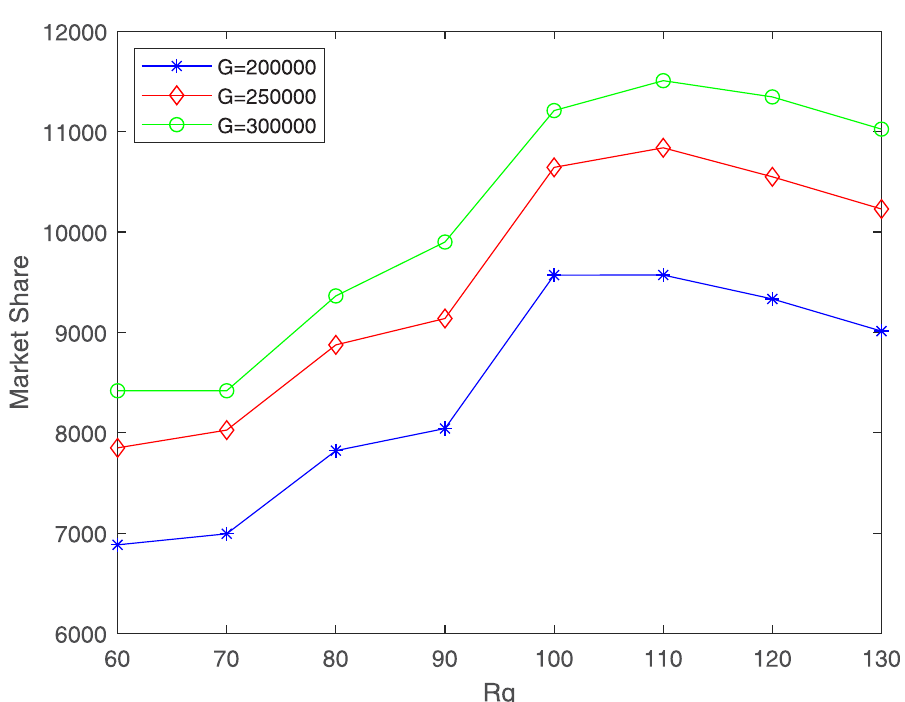
( R = 40, δ = 100, γ 1 = 0.4, γ 2 = 0.6). q c